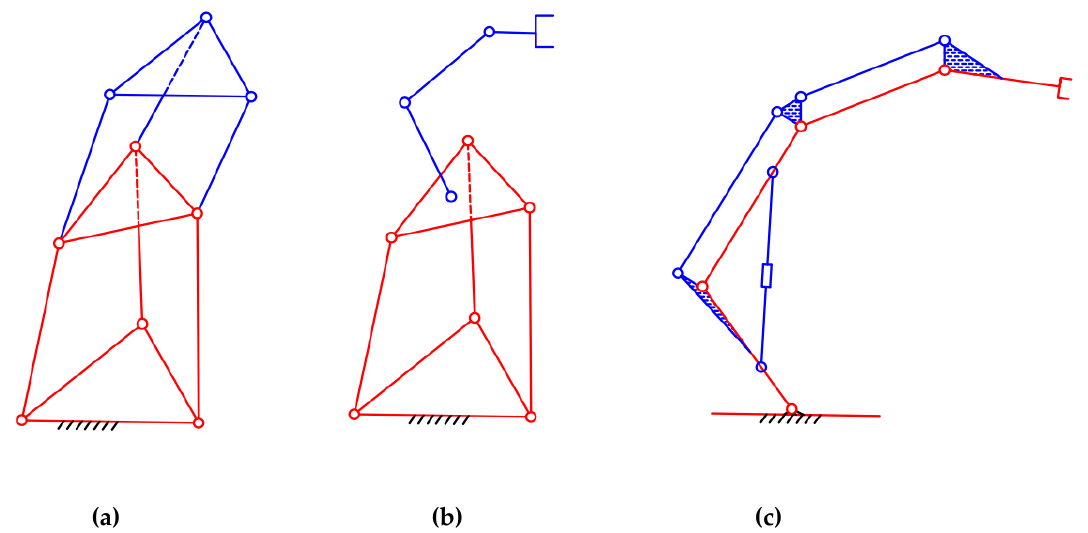
Figure 1. Three main classes of the hybrid robots: ( a ) Class I; ( b ) Class II and ( c ) Class III